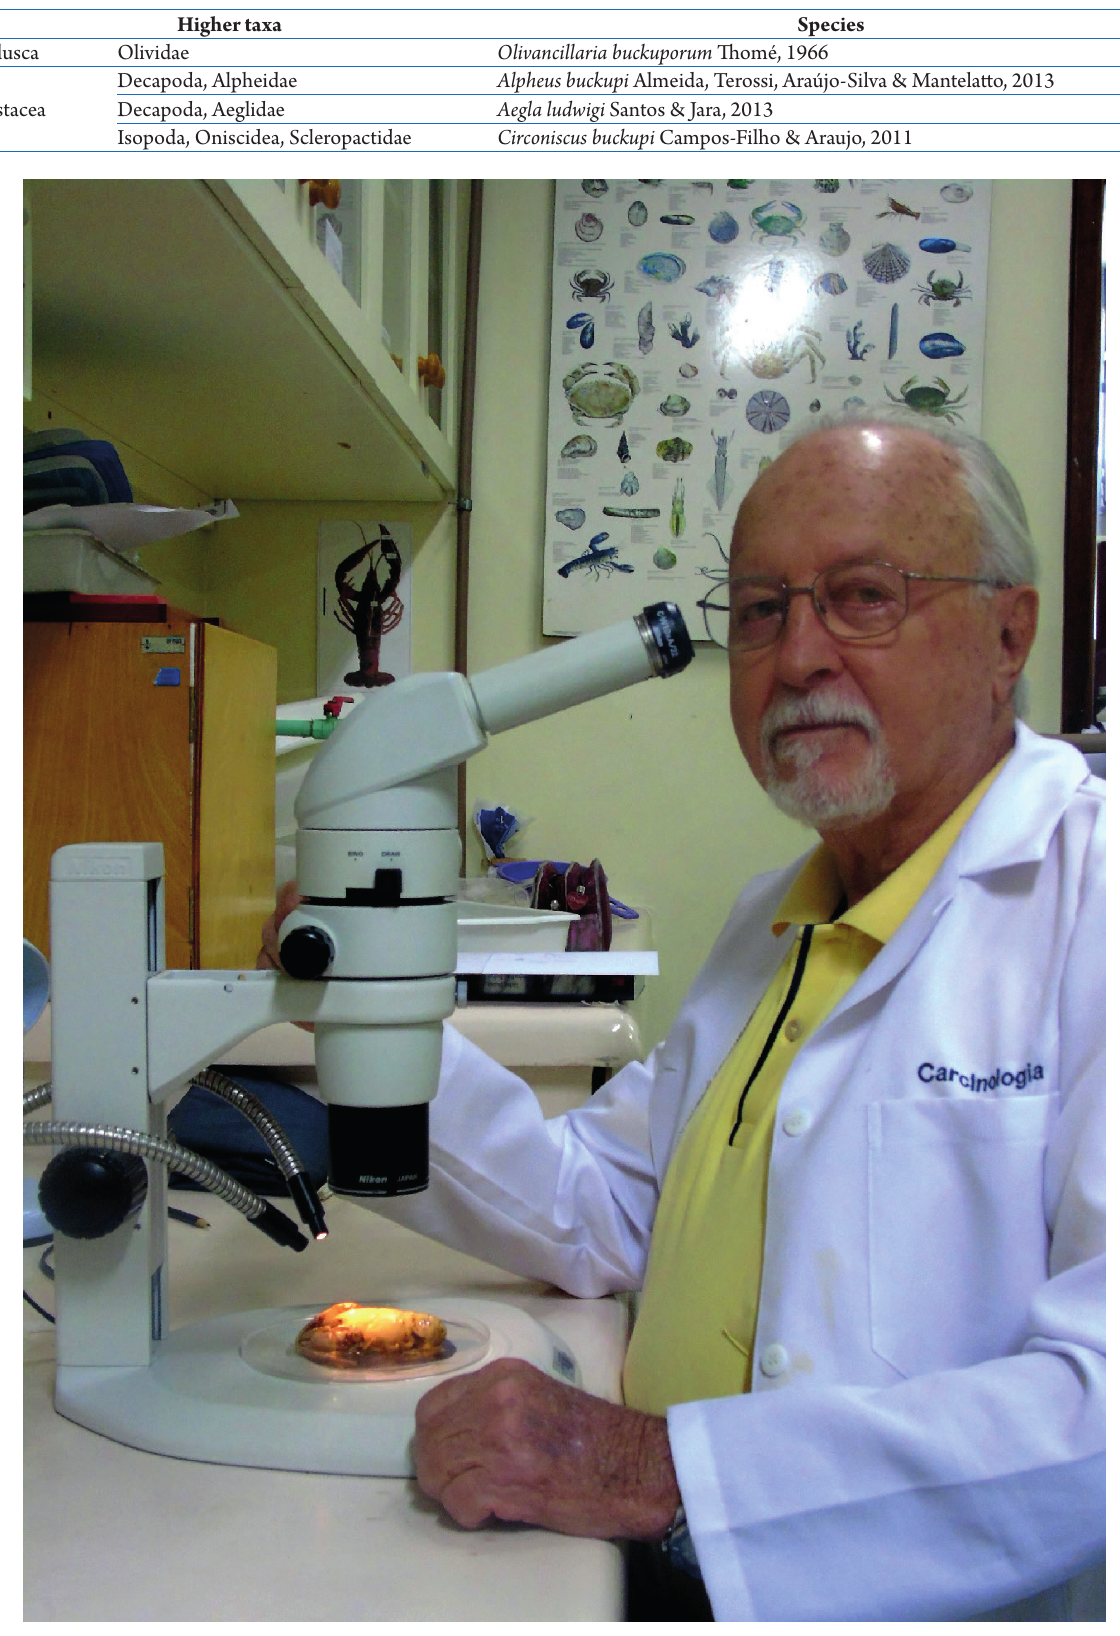
Table 2. Species described in honor of Ludwig Buckup.